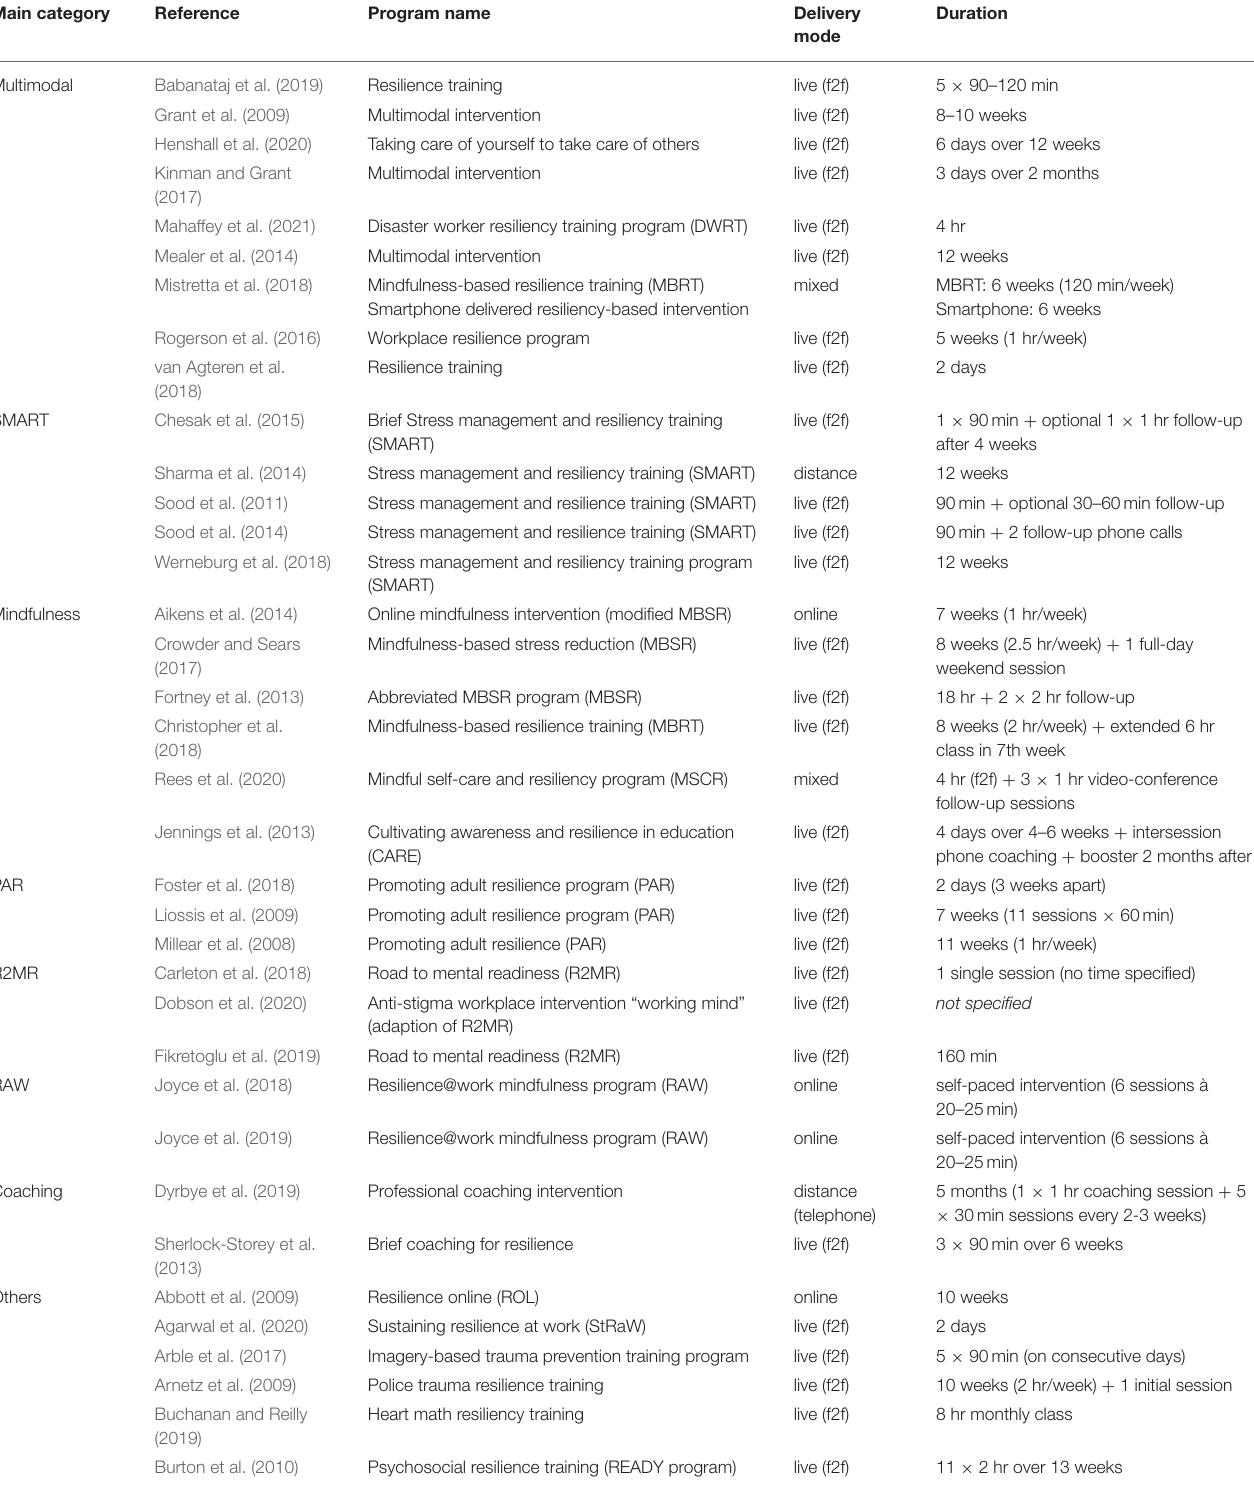
TABLE 1 | Resilience training